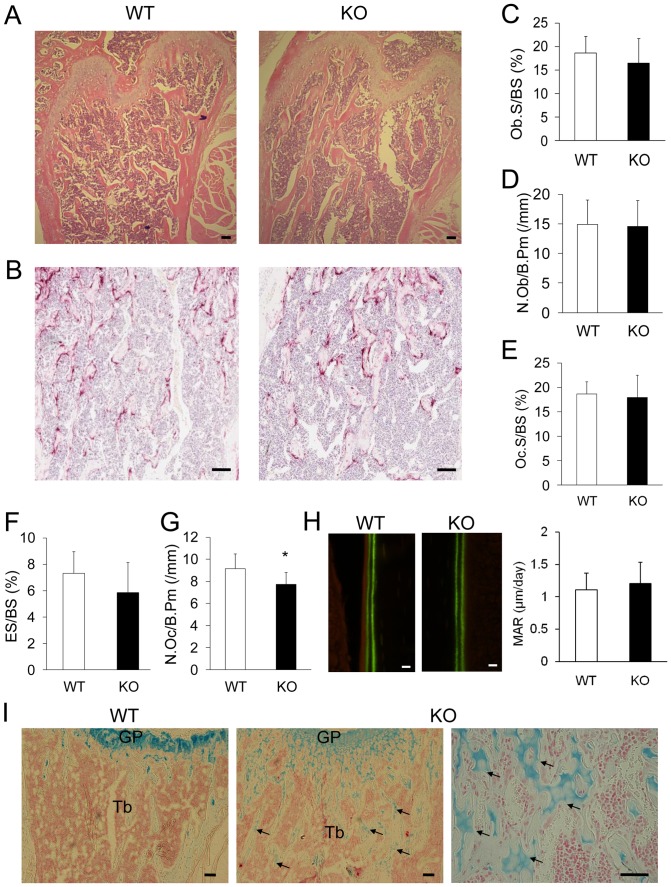
Osteoclast deficiencies in trabecular bone of PKC-δ KO mice.(A–B) Histological sections of three-month-old female PKC-δ KO mice and age-sex matched WT mice femurs stained with H&E (A) and TRAP (B), scale bar represents 100 µm. (C–G) Osteoblast surface (Ob.S/BS), number of osteoblasts (N.Ob/B.Pm), osteoclast surface (Oc.S/BS), eroded surface (ES/BS) and number of osteoclasts (N.Oc/B.Pm) was analyzed for eight pairs (n = 8) of three-month-old, female PKC-δ KO and WT mice femurs. (H) Bone mineral apposition rate measured from calcein-labeled bones, scale bar represents 10 µm. (I) Alcian Blue stained histological sections; far right image shows a higher magnification micrograph of unresorbed cartilage in PKC-δ KO bone, scale bar represents 100 µm. GP; growth plate, Tb; Trabecular bone. Arrows indicate the remnants of unremodeled cartilage matrix within trabecular bone. Bar charts represent mean ± standard deviation. *, p-value <0.05. **, p-value<0.01.